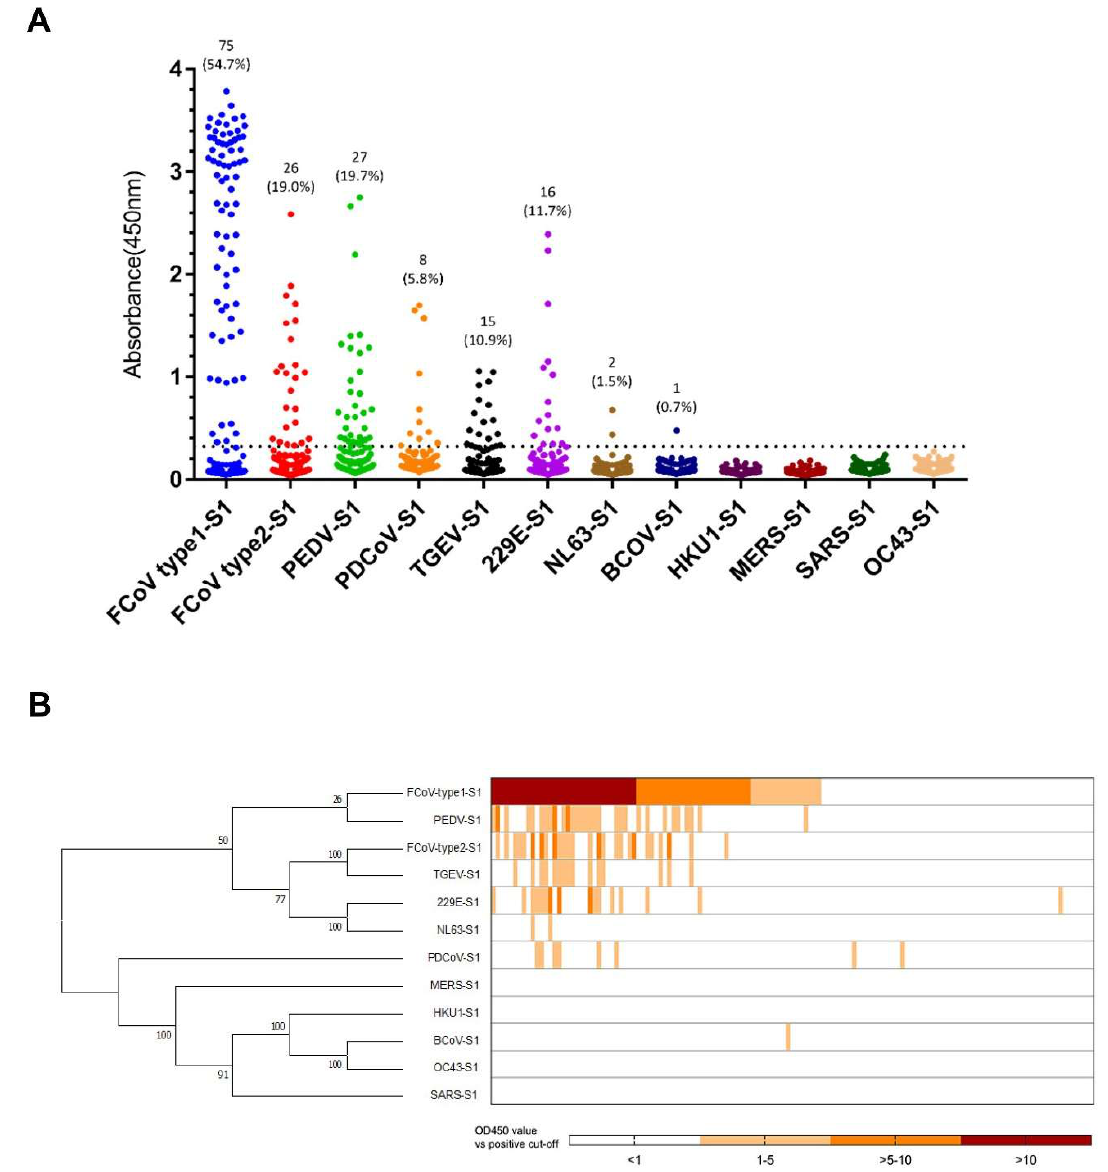
Figure 1. ELISA-reactivity of feline serum samples against S1 proteins of different coronaviruses. ( A ) Reactivity of feline serum samples ( n = 137) against 12 coronavirus S1 antigens was determined by ELISA. The number and percentage of seropositive samples are indicated for each S1 protein. The dashed line is the positive cut-off. Each dot represents one individual sample within each antigen panel. ( B ) Relative ELISA (OD450 values divided by cut-off value) results are displayed as a heat map. Different S1 antigens were grouped by amino acid sequence phylogeny (left panel) using MEGA7. Each column of the heat map represents an individual sample, and columns were arranged in a descending order based on ELISA-reactivity against feline coronavirus (FCoV) type 1. Table 1. Numbers of positive cat samples and different combinations of reactivity found. The number of positive sera against each individual S1 is shown in the bottom row. Positive ELISA reactions are colored in orange. Cut-off value was determined as the 5-fold over the OD450 of negative sera. S1 Antigens of Different Coronaviruses Number of Cats (Total =137)